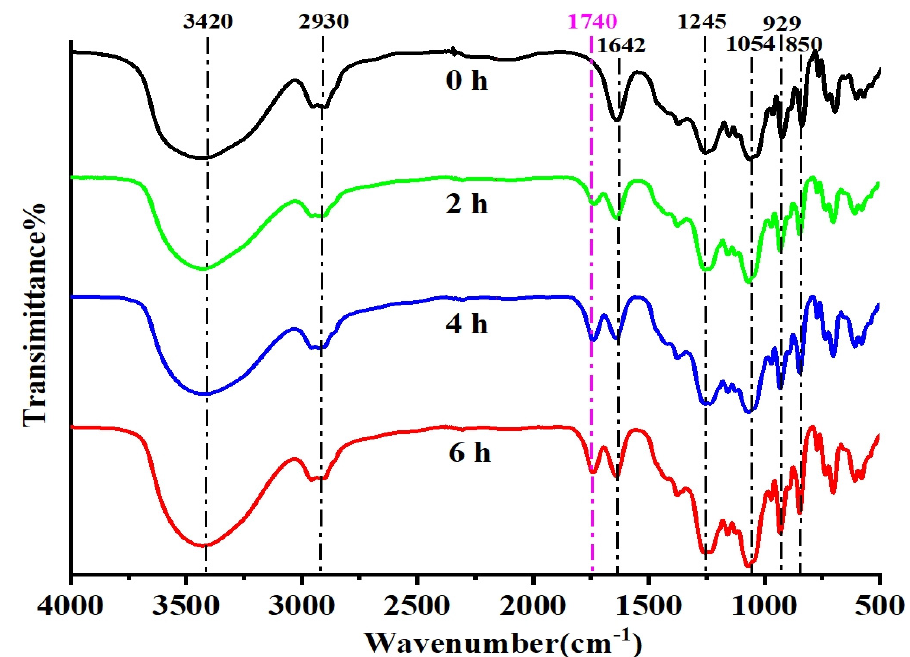
Figure 4. FT − IR spectra of κ -carrageenan after 0 h, 2 h, 4 h, and 6 h photocatalytic reaction. To further explore the possible structural changes caused by photocatalysis degrada- tion, 1 H NMR, 13 C NMR, and HSQC spectra (Figure 5) of DC-6 were investigated. The cross peaks at 4.63/102.1 ppm and 5.08/94.5 ppm in the HSQC spectrum were identified as anomeric proton/carbon signals of Gal4S and AnGal, respectively. Other 1 H and 13 C chemical shifts were also assigned in Table 1. Comparison of the NMR signals with those of κ -carrageenan [43,44] indicates that DC-6 has no obviously structural changes. It is worth mentioning that no carbon signal was observed at 66.4 ppm corresponding to the C-4 posi- tion of galactose without sulfate substitutions [45], indicating no obvious desulphurization occurs in the photocatalytic degradation.